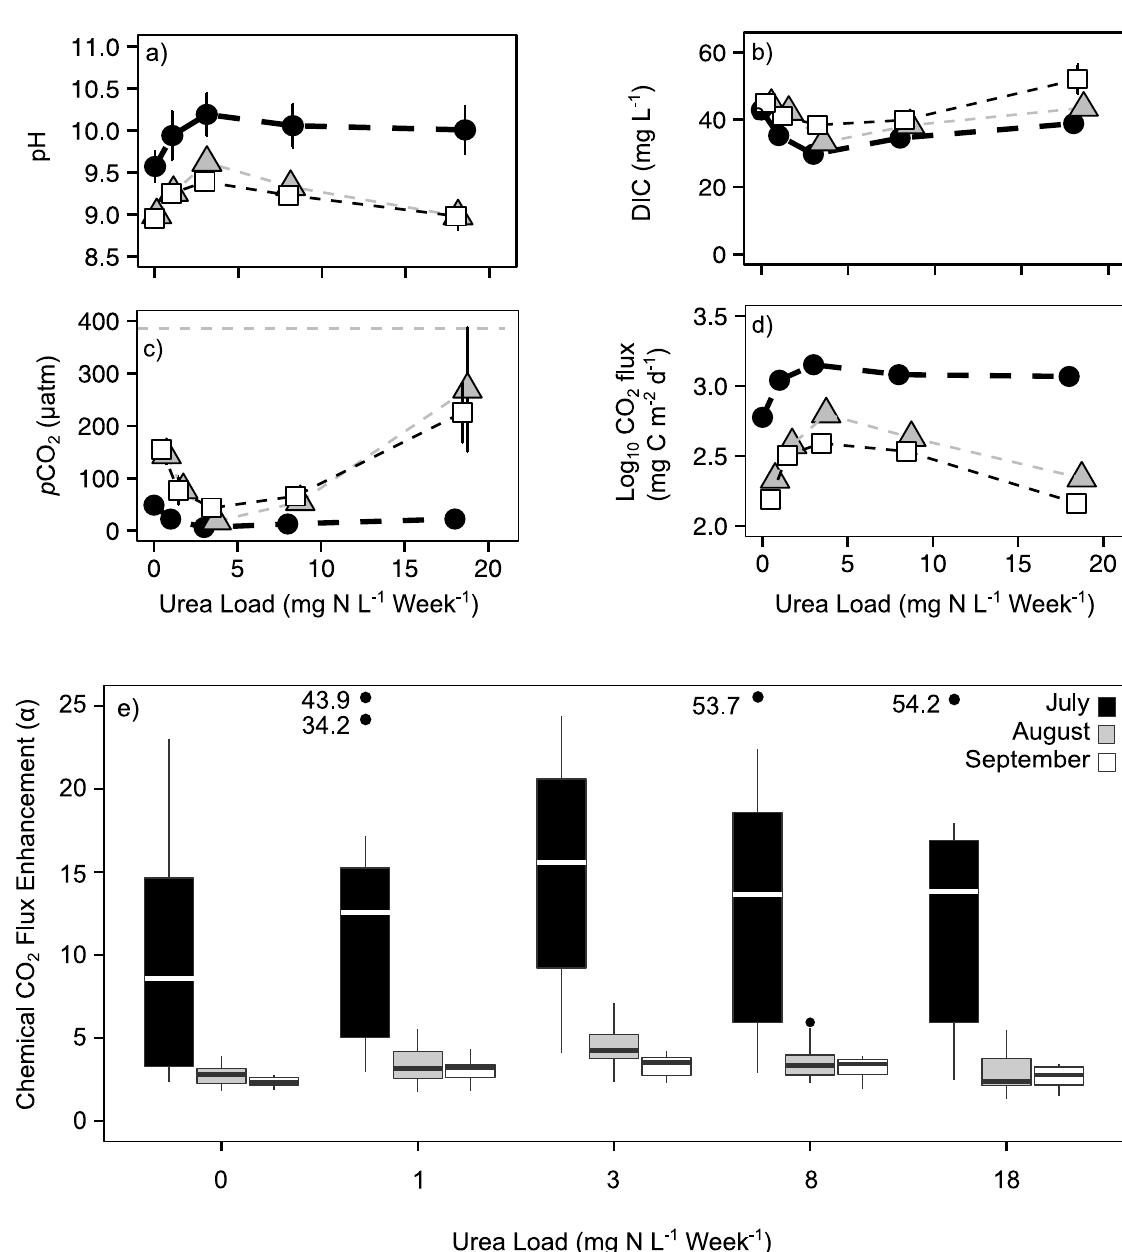
Fig 3. Effect of N influx rate (mg N L -1 week -1 ) on carbon cycling and chemically-enhanced CO 2 flux in mesocosms. Data from days 7–21 were averaged for (a) pH, (b) DIC, (c) partial pressure of CO 2 ( p CO 2 ) and for (d) the rate of air-water flux of CO 2 (positivevalues represent influx). In July, averages of days 7–14 were used for pH, p CO 2 and emissionsrates. In all cases, symbols are consistent with Fig 2. Error bars = ± 1 S.E, and n = 9 ( n = 6 in July). (e) The calculatedrole of chemicalenhancement of CO 2 fluxes for each month, by treatment level. Boxes depict the median(central line), as well as 1 st and 3 rd quartile(box limits). The horizontaldashedgrey line in panel c depicts atmospheric p CO 2 (385 μ